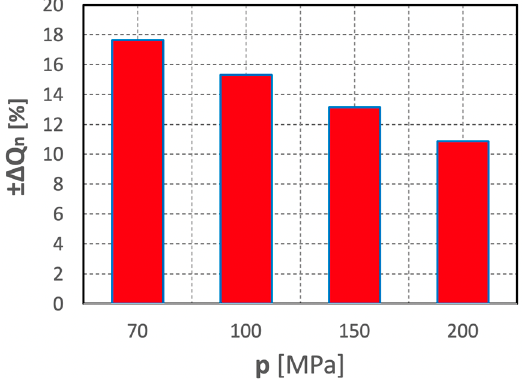
Figure 24. Influence of water jet pressure on the distributions of relative concretion comminution values, during the comminution in a hydro-jet mill (for d w = 0.7 mm, d h = 2.4 mm, s = 10 mm).